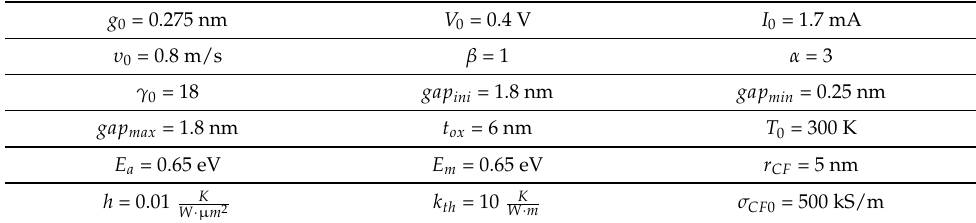
Table 4. Fitting parameters for the UGR-VCMCF